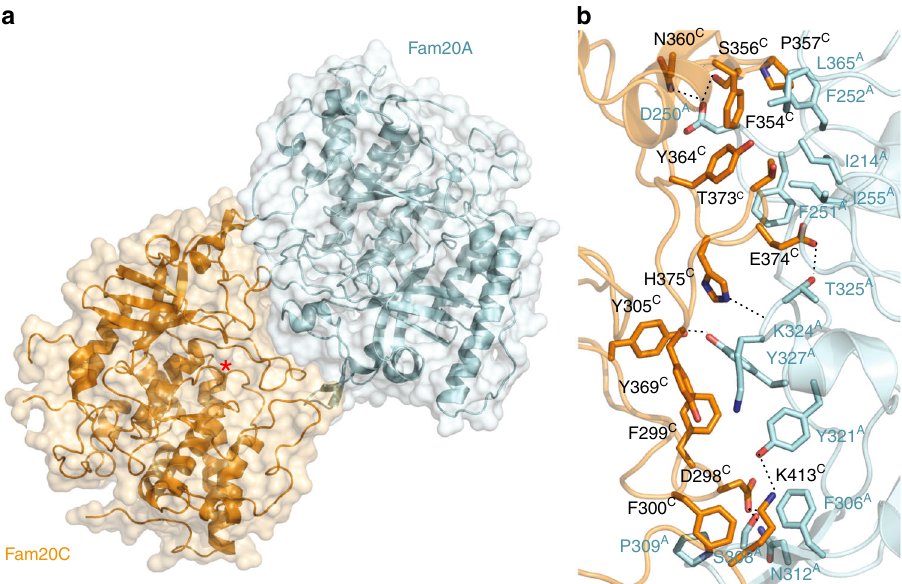
Fig. 1 Crystal structure of the human Fam20A − Fam20C complex. a Overall view of the human Fam20A − Fam20C heterodimer. The active site of Fam20C is indicated with an asterisk. b Detailed view of the Fam20A − Fam20C interface. Superscripts A and C denote residues in Fam20A and Fam20C, respectively. Hydrogen bonds are indicated by dashed